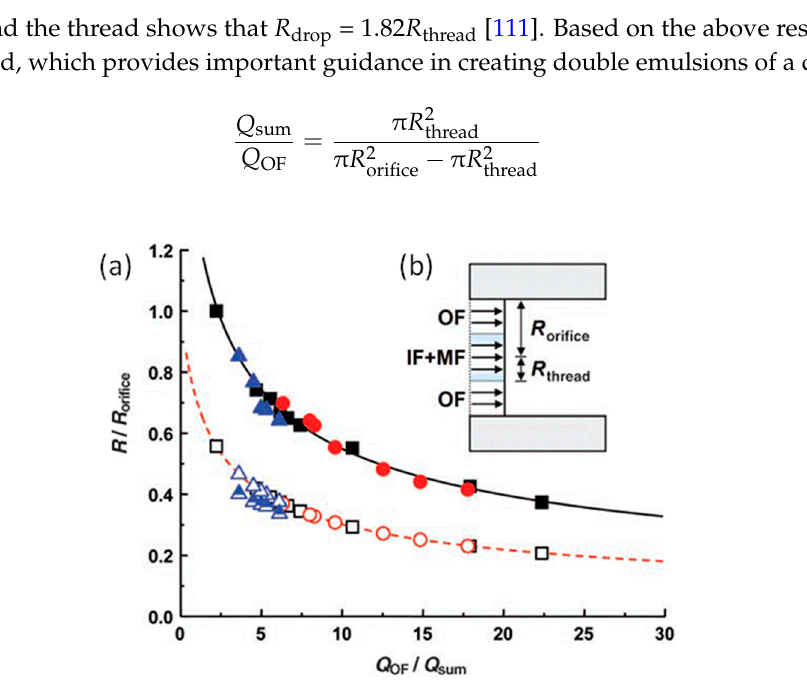
Figure 8. ( a ) Dependence of R thread /R orifice on the scaled flow rate Q OF /Q sum [110]. The open symbols represent the R thread for different liquids and double emulsions consisting of a single silicon drop surrounded by a liquid shell (3 Q IF = Q MF , triangle). The dashed line represents the predicted R thread . R drop values are represented with solid identical symbols. Half-filled triangles correspond to the radius of the internal droplets of the double emulsions. The solid line represents the predicted R drop . ( b ) The flat velocity profile of the flow as it enters the capillary tube [110]. Reproduced with permission from Kim, J.W., et al., Angewandte Chemie ; published by John Wiley and Sons, 2007.